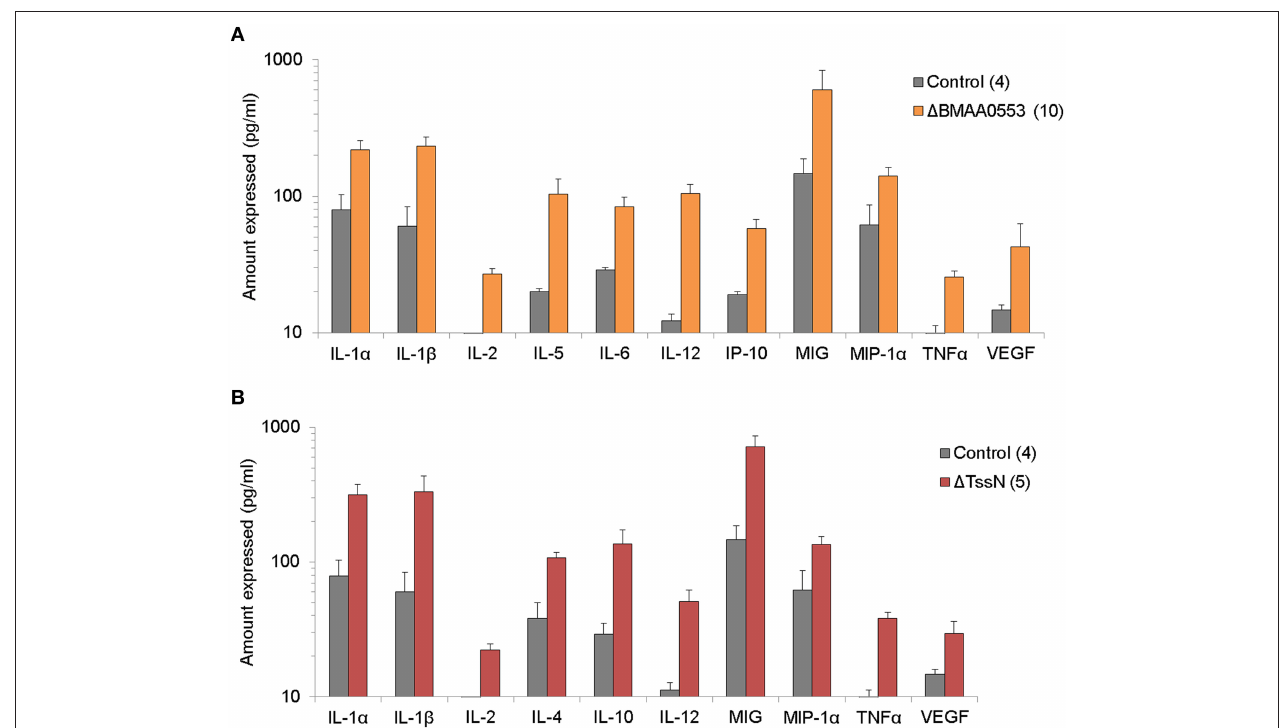
FIGURE 5 | Cytokine expression profile. The levels of 20 cytokines/chemokines present in spleen extract supernatants were examined in mice after aerosol exposure to 1 BMA0553 (A) or 1 TssN (B) and compared to control mice 21 days postinfection. Only the expression levels of cytokines/chemokines that were at least two-fold above that of naïve mice are shown. All differences shown are statistically significant at p < 0.001